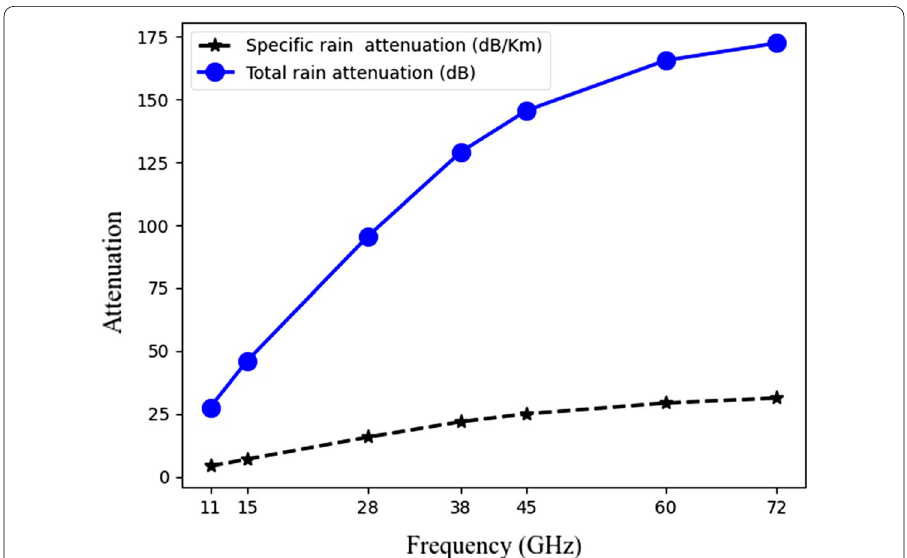
Fig. 8 Attenuation versus frequency of operation. The black line graph shows specific path attenuation (dB/km) versus frequency. This graph shows the specific path attenuation values for selected frequency of operation which are 11, 15, 28, 38, 45, 60 and 72 GHz. The blue line depicts total rain attenuation versus frequency of operation. This graph also shows the specific path attenuation values for selected frequency of operation which are 11, 15, 28, 38, 45, 60 and 72